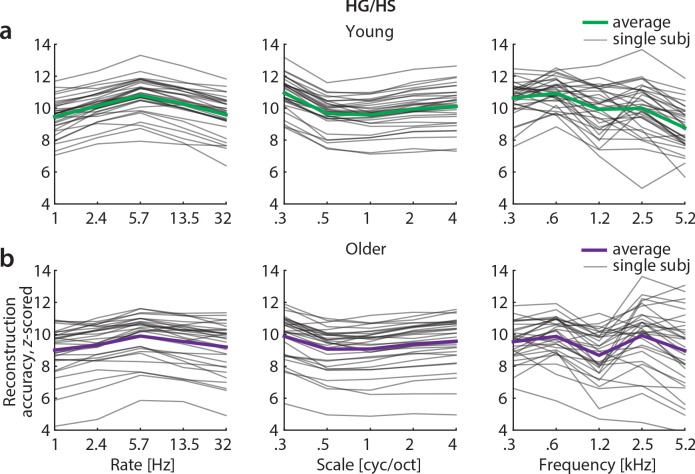
Z-scored reconstruction accuracies from Heschl’s gyrus/sulcus.Single subject and median reconstruction accuracy profiles for temporal rate, spectral scale and frequency z-scored with respect to the empirical null distribution for young (a) and older (b) participants. Note that all z-values exceed 1.96 and are thus significant at p<0.05.